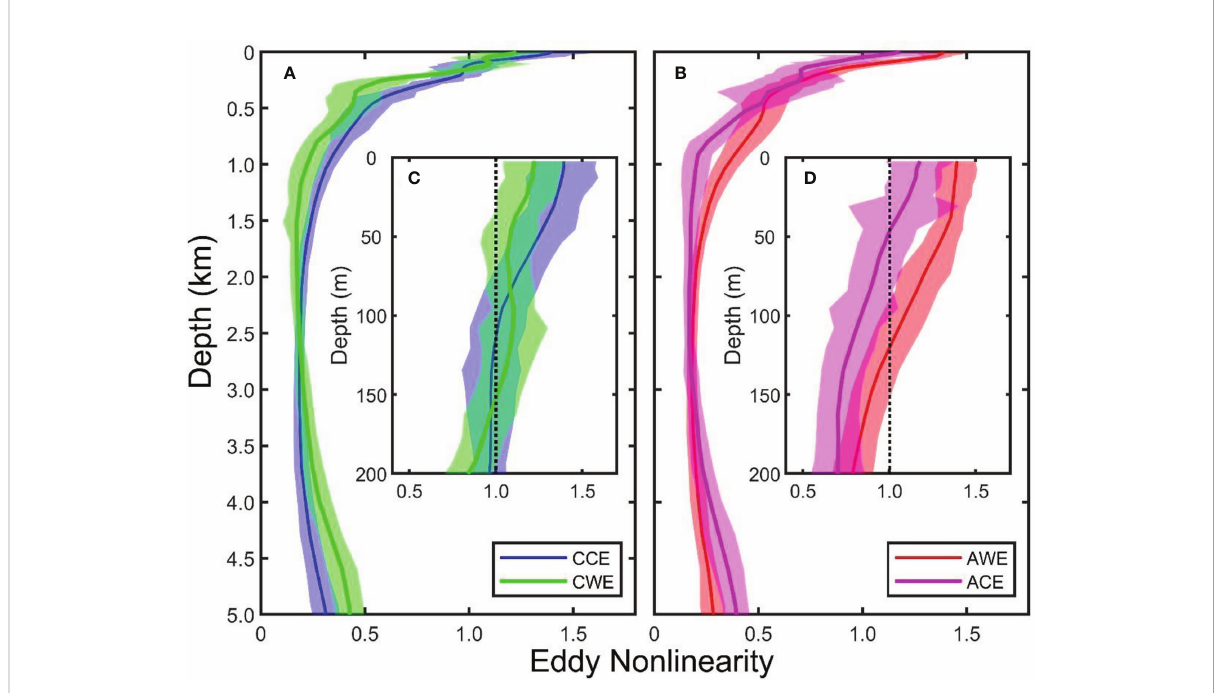
FIGURE 14 Vertical distribution of eddy nonlinearity from the four types of eddies. Blue, red, green, and magenta represent cyclonic cold-core eddy, anticyclonic warm-core eddy, cyclonic warm-core eddy, and anticyclonic cold-core eddy, respectively. The shaded areas represent the corresponding standard deviation. (A) represents the vertical pro fi les of cyclonic cold-core eddy and cyclonic warm-core eddy, and (B) represents the vertical pro fi les of anticyclonic cold-core eddy and anticyclonic warm-core eddy. (C) and (D) are enlarged images of the upper 200 m layer of (A , B) ,